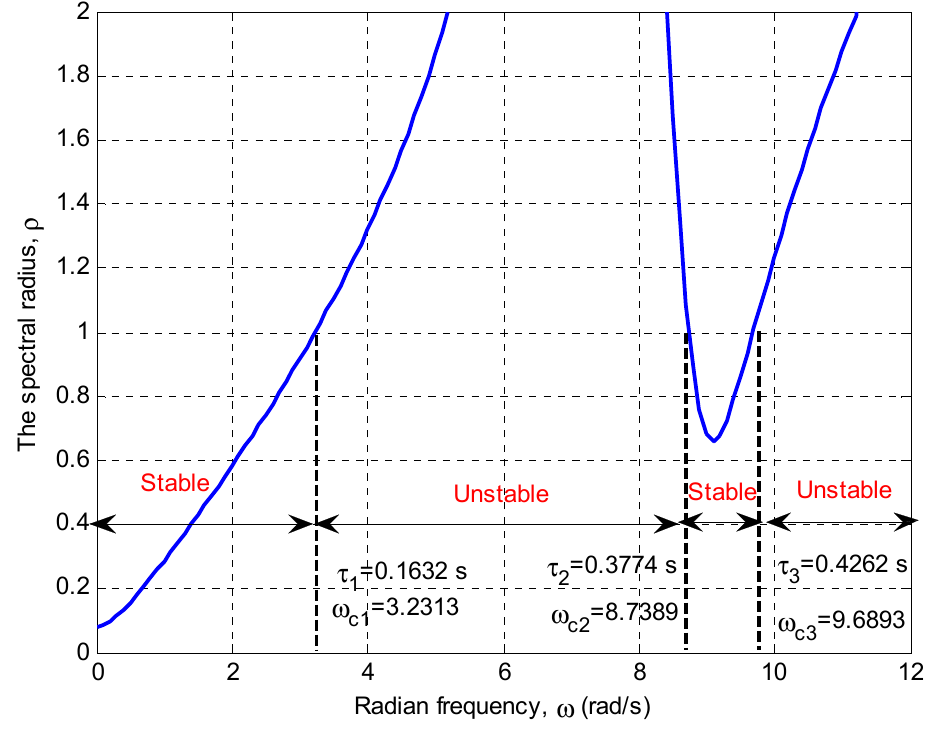
Figure 23. The spectral radius as function of ω .